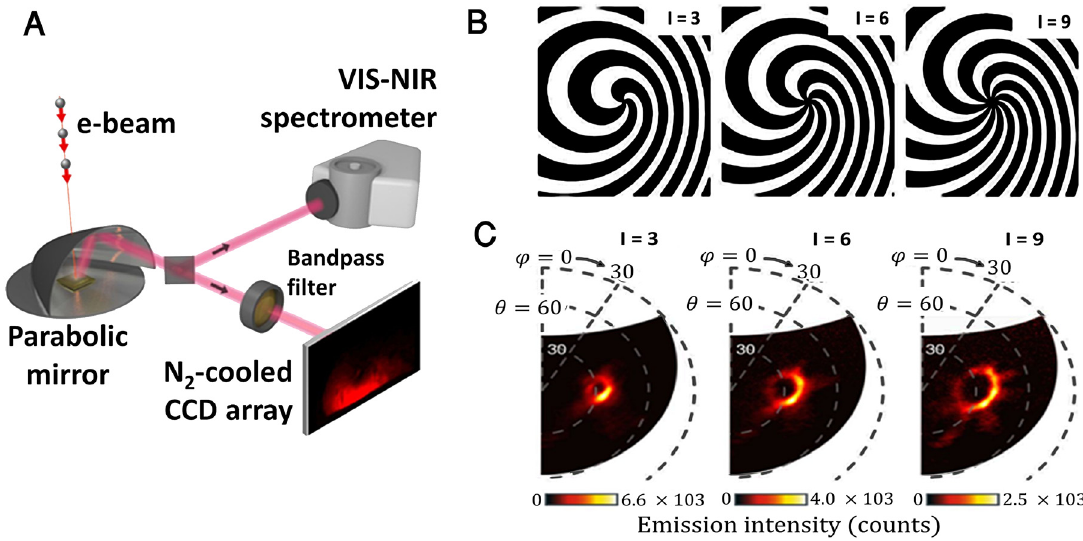
Figure8: (A)Schematicofthescanningelectronmicroscope – basedsystemforangle-resolvedelectron-inducedlightemissionspectroscopy. (B) Central portions of binary holographic masks for electron beam – induced generation of optical vortex beams with topological charge at l = 3, 6, and 9. (C) Corresponding angle-resolved emission intensity distribution maps (electron beam current = 5.5 – 6.1 nA; integration time = 30 s)